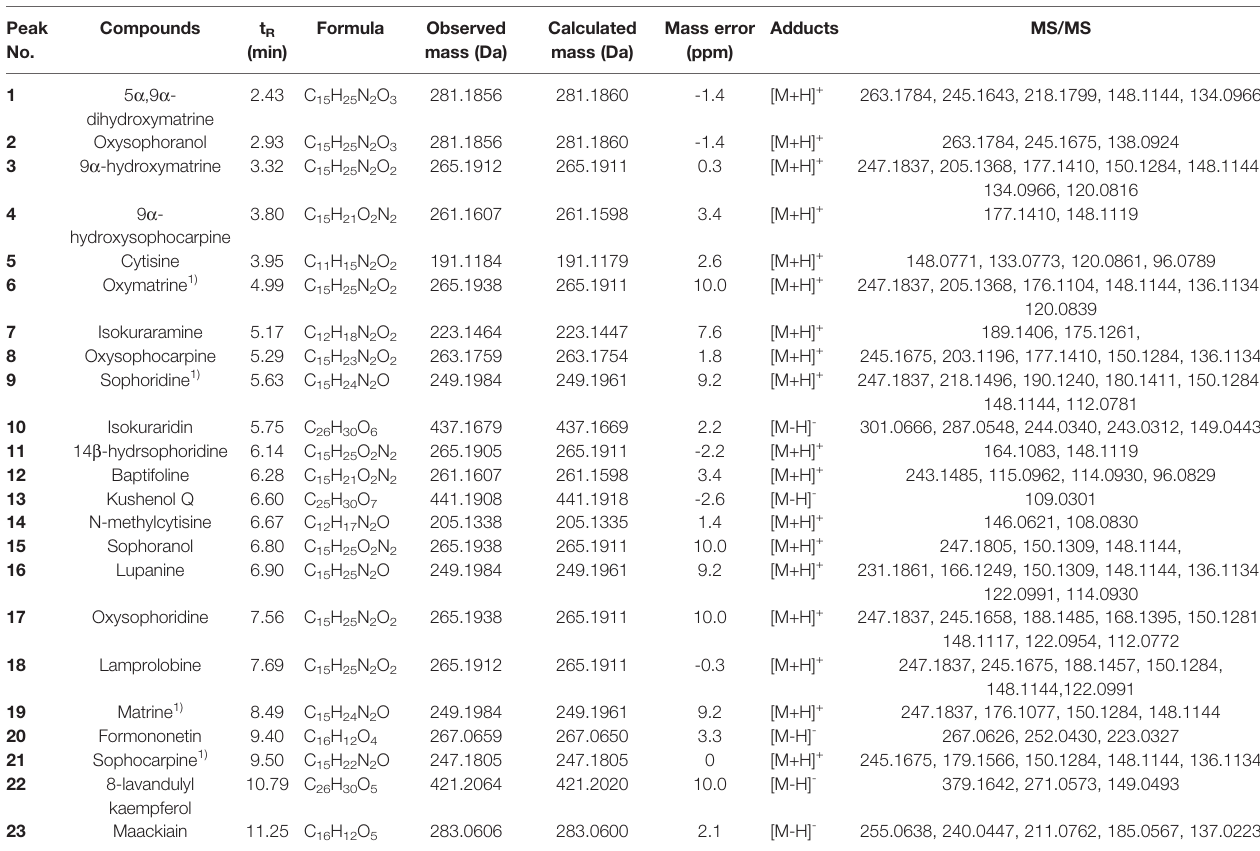
TABLE 1 | Compounds of CKI detected by